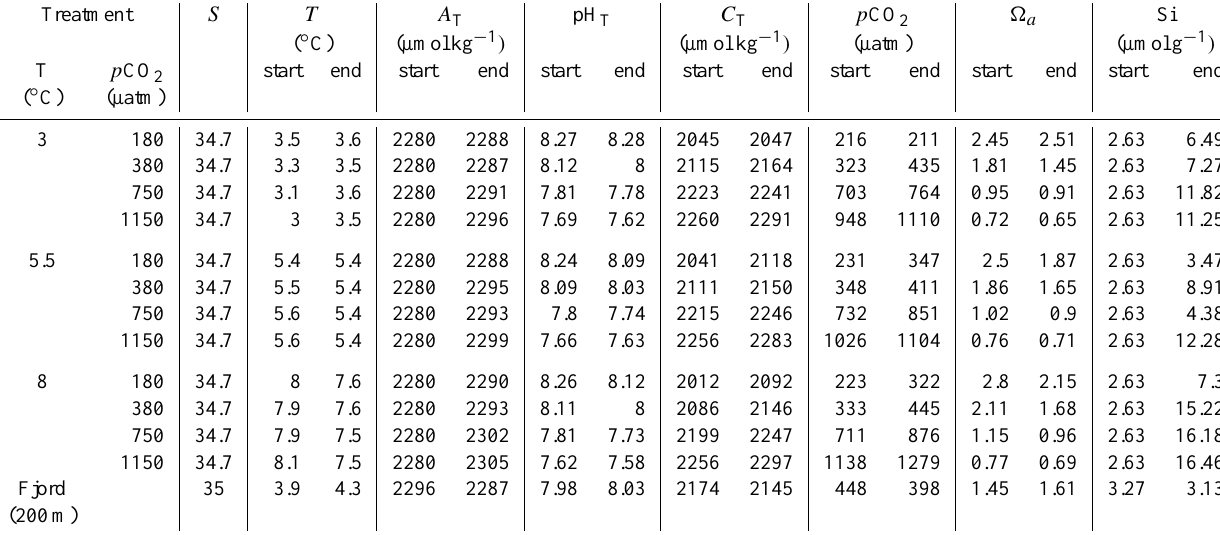
Table 1. Mean carbonate system parameters calculated from samples taken from the prepared manipulated seawater at start and from all experimental jars at the end of the experimental period. The treatment column refers to target temperature and p CO 2 , of which the p CO 2 levels refer to glacial partial pressure CO 2 (180µatm, 18kyrBC), present day p CO 2 (380µatm, year 1990), high p CO 2 I (750µatm, year 2080), and high p CO 2 II (1150µatm, > year 2100). The concentration of total CO 2 ( C T ) , partial pressure of CO 2 ( p CO 2 ) , and the saturation